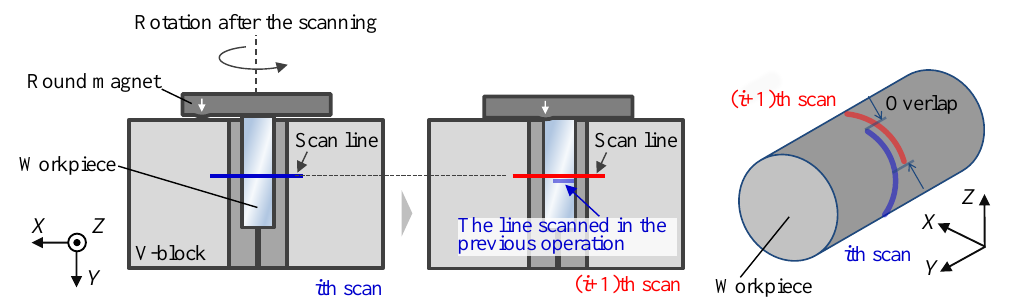
Figure 5. The influence of the workpiece misalignment along its axial direction.